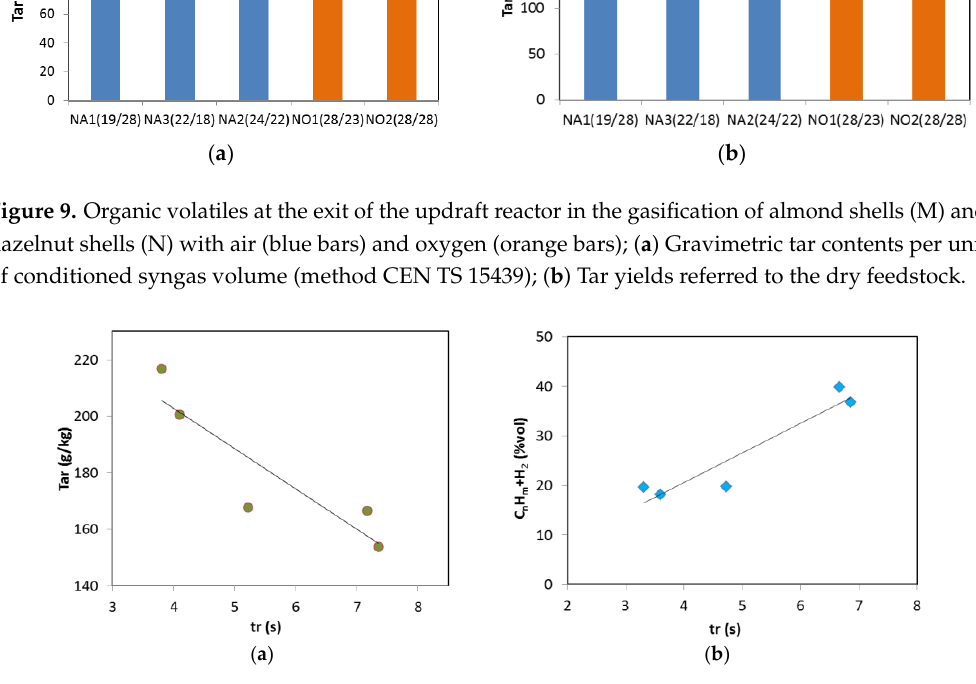
Figure 10. Gasification of hazelnut shells (N): ( a ) Yield of tar and ( b ) Incondensable hydrocarbons +H 2 concentration as function of the residence time of the syngas in the bed.